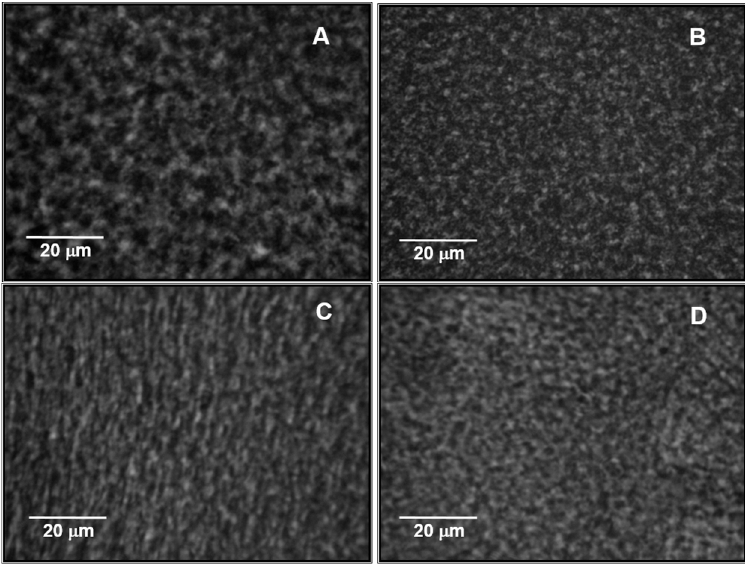
Figure 6. Digital images of acid gels, C NaCAS 3 wt %, R 0.5 and T 25 °C: ( A ) without GX; ( B ) C GX 0.10 wt %; ( C ) C GX 0.15 wt % and ( D ) C GX 0.20 wt %; oil immersion objective of 100× on an inverted microscope which was coupled to a digital camera with a 52 mm adaptor and 9.1× zoom.